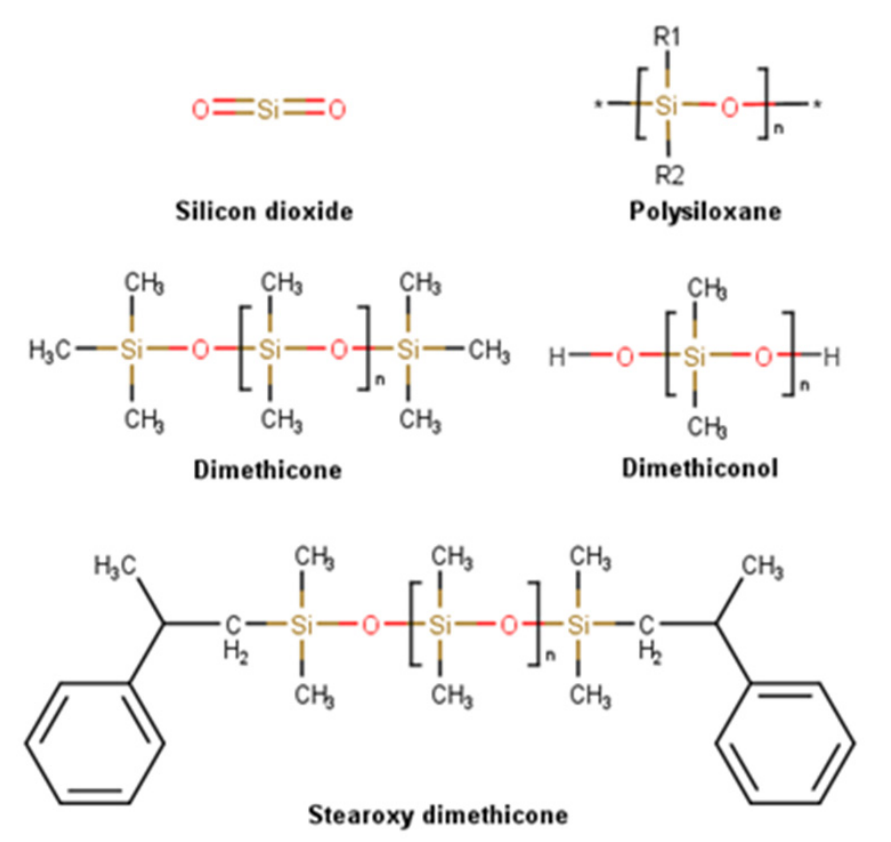
Figure 9. Chemical structure of silicon dioxide, polysiloxane, dimethicone, dimethiconol, and stearoxy dimethicone.